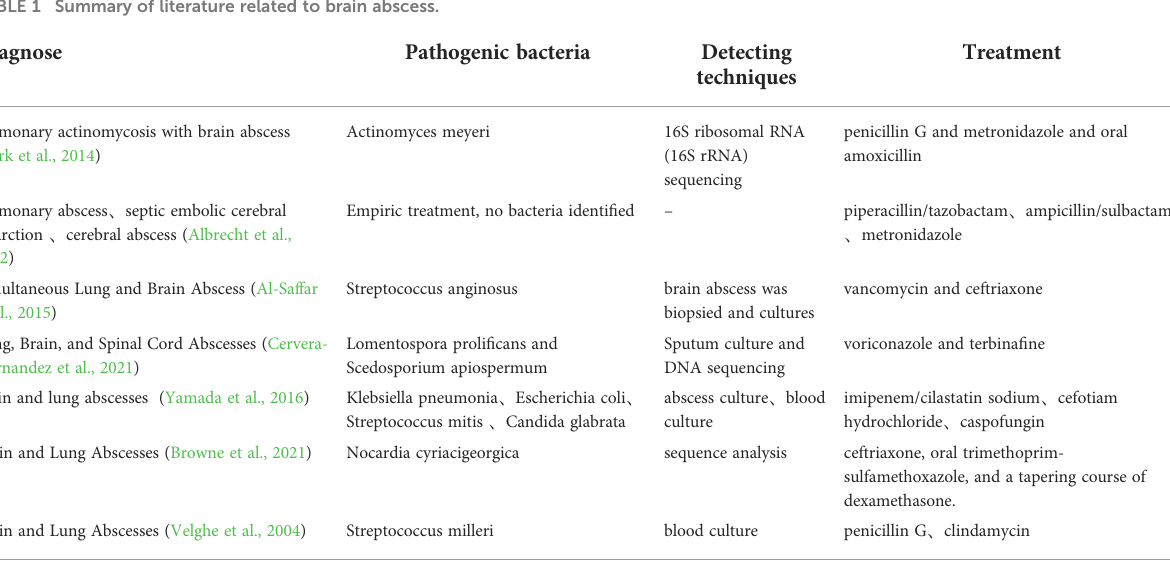
TABLE 1 Summary of literature related to brain